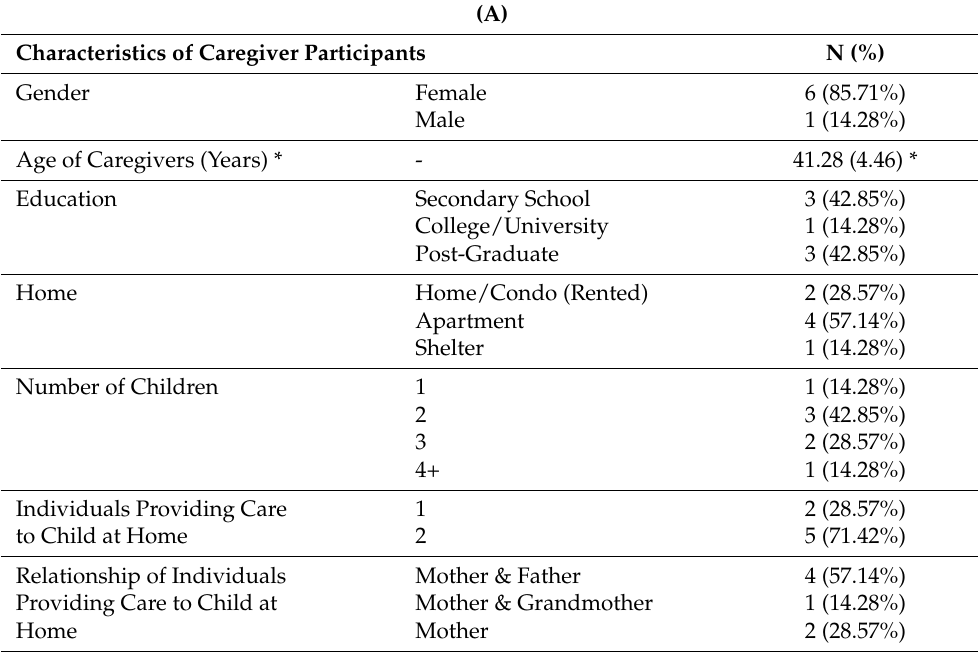
Table 1. ( A ). Demographic Characteristics of Caregiver Participants (n = 7). ( B ). Demographic Characteristics of Care Provider Participants (n =